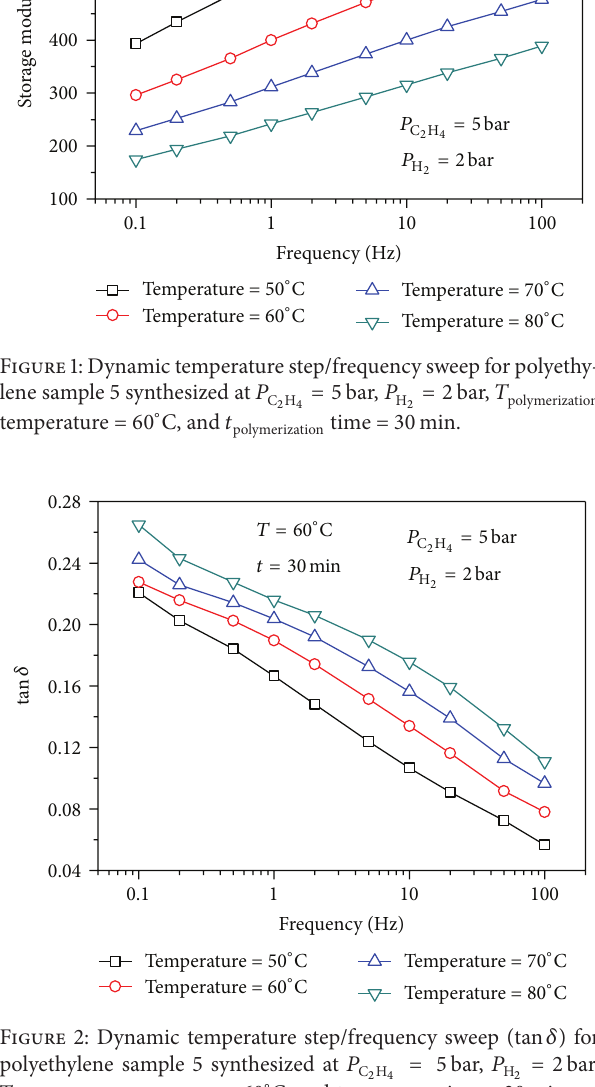
= 5 bar, 𝑃 = 2 bar, C 2 H 4 H 2 time = 30 polymerization